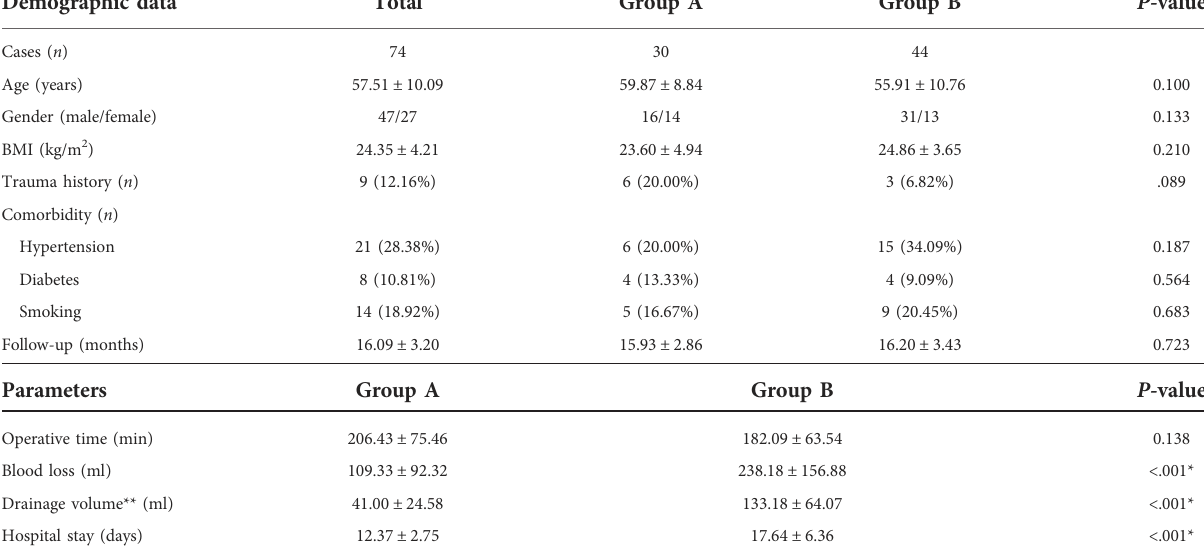
TABLE 1 Demographic data and perioperative parameters of two groups.